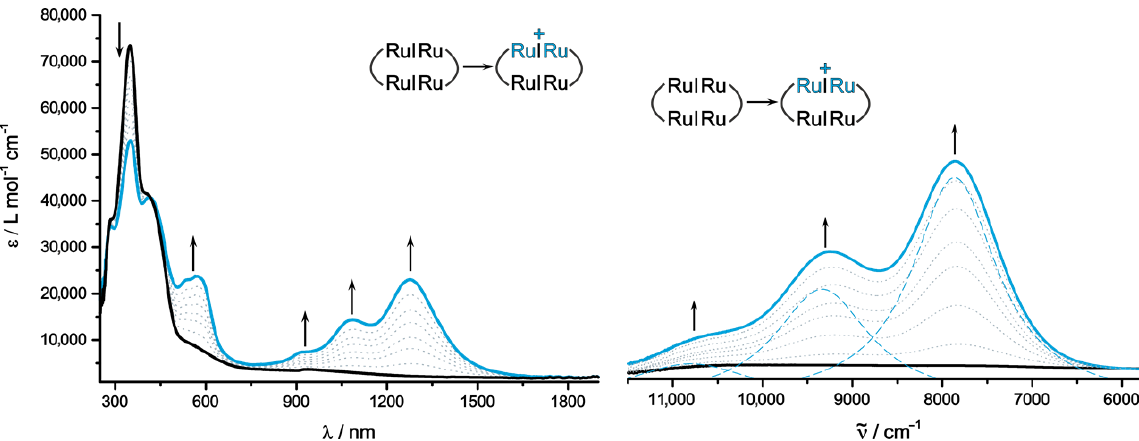
Figure 9. Changes in the UV/Vis/NIR spectrum (DCE, 0.05 M NBu 4 BAr F24 , r.t.) of 2 Ru 2 Ph-Croc during the first oxidation ( left ); magnification of the IR/NIR part of the spectrum ( right ). The broken blue lines denote the positions of the individual sub-bands according to spectral deconvolution. Table 3. UV/Vis/NIR data of the complexes in their various oxidation states. a